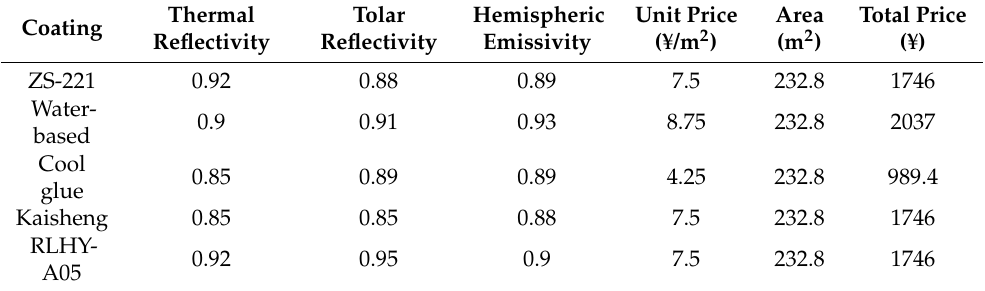
Table 7. Physical parameters and prices of heat-reflective and thermal insulation coating of roof.